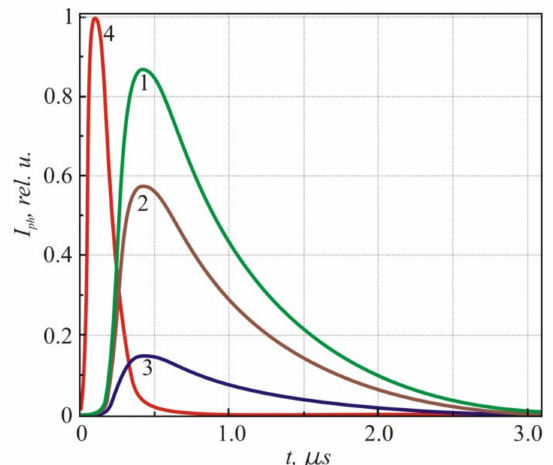
Figure 6. Photocurrent pulses across the PbTe p-n junction at different temperatures: 1—100 K; 2—150 K; 3—180 K. For comparison in the timescale, Trace 4 (red) represents the laser